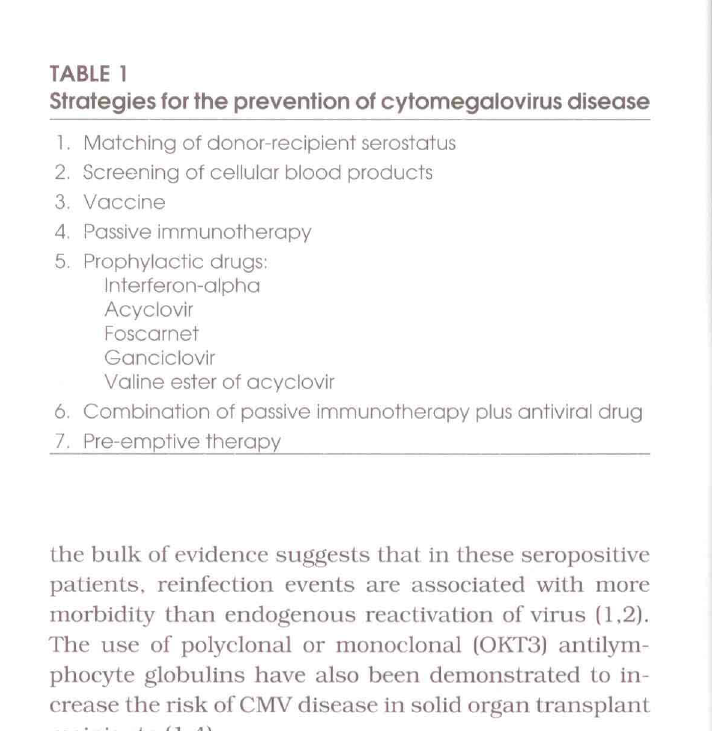
Strategies for the prevention of cytomegalovirus